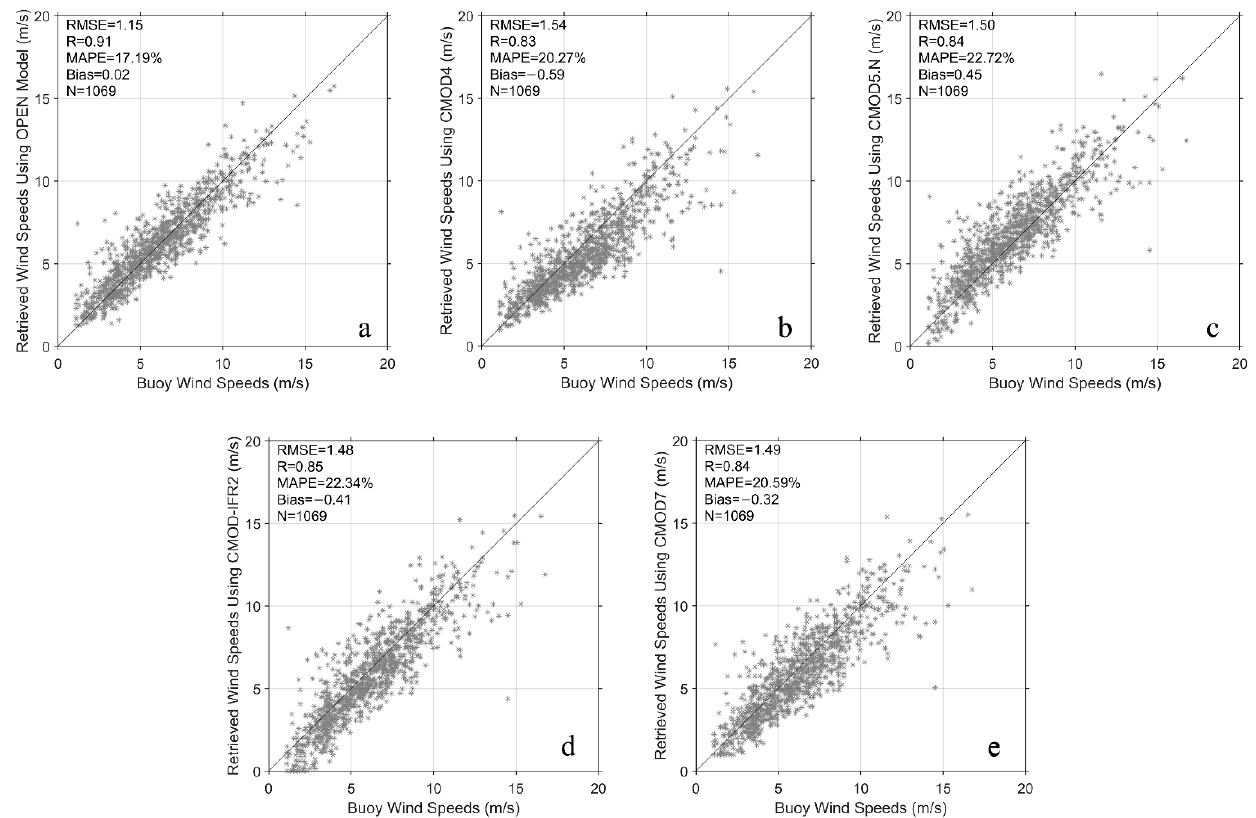
Figure 6. Comparisons of collocated NDBC buoy winds with retrieved wind speeds from the test data using ( a ) OPEN model, ( b ) CMOD4, ( c ) CMOD5.N, ( d ) CMOD-IFR2, and ( e ) CMOD7.